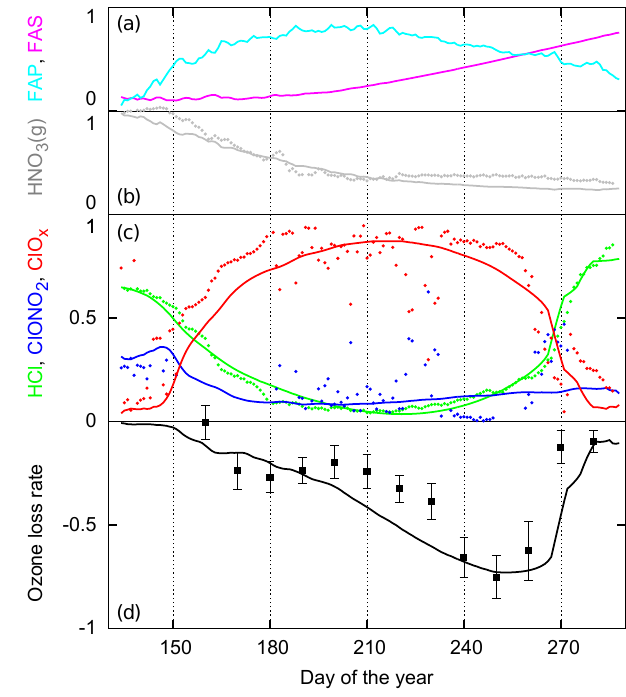
Figure 3. As Fig. 2, but for the Antarctic winter